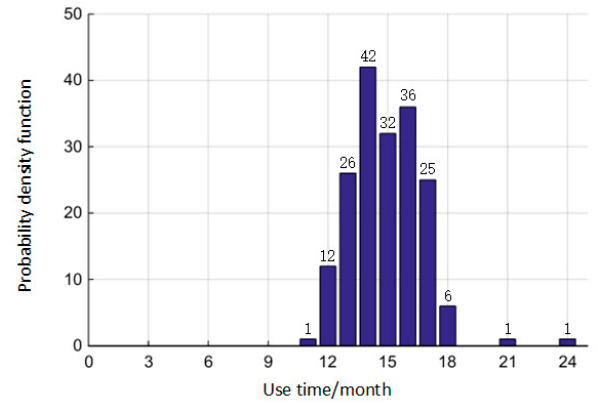
Figure 14. The frequency distribution histogram of use time.